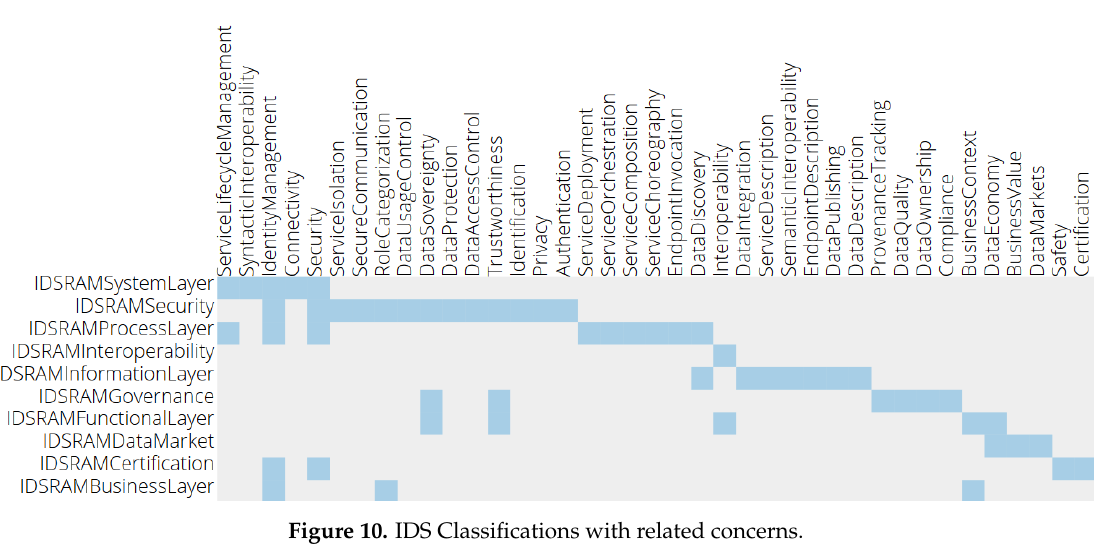
Figure 9. RAMI4.0 Layers with related concerns.